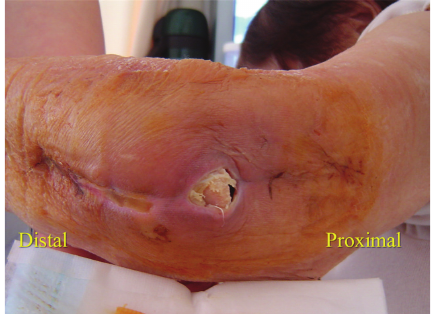
Figure 1: An area of skin necrosis occurred two weeks after surgery.